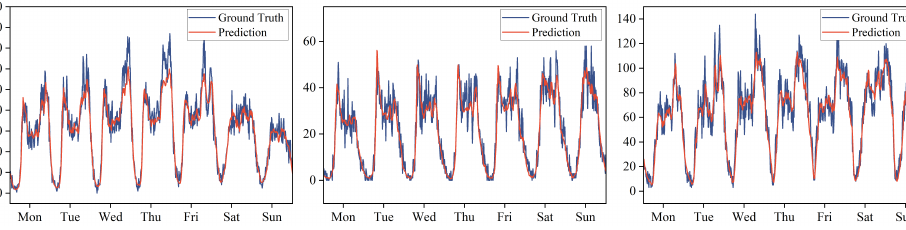
Figure 12. Visualization of travel demand for one week in three regions on